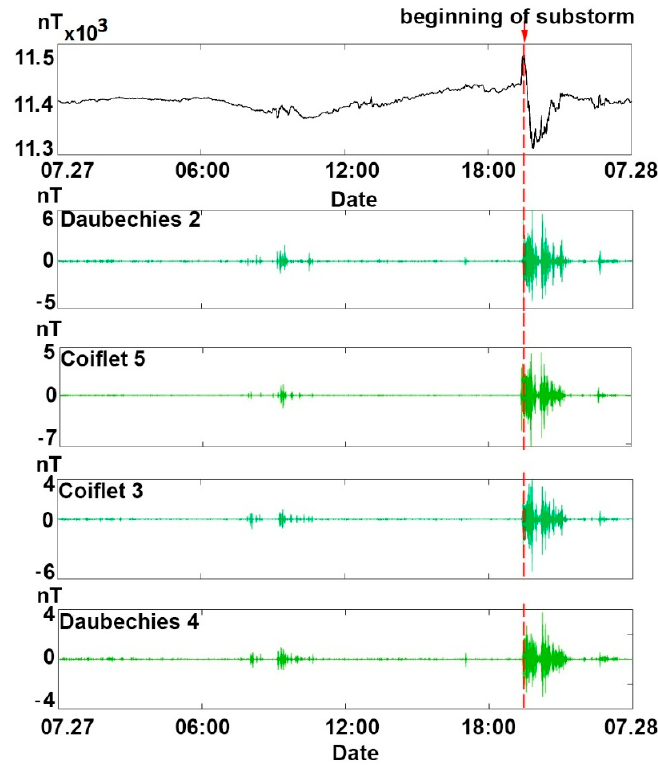
Figure 3. Estimation of the approximation error for different bases.